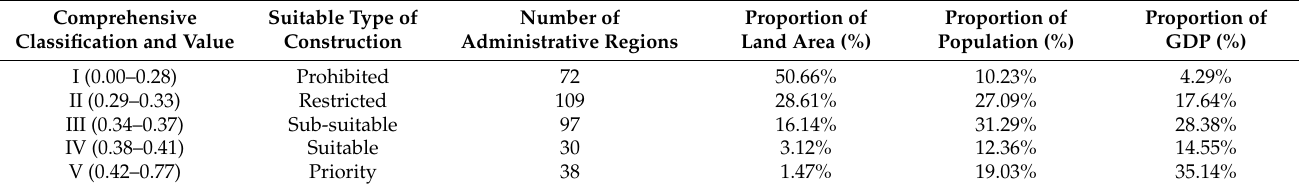
Table 2. Classification of suitability of urban construction land (SUCL) in the upper reaches of the Yangtze River. Comprehensive Classification and